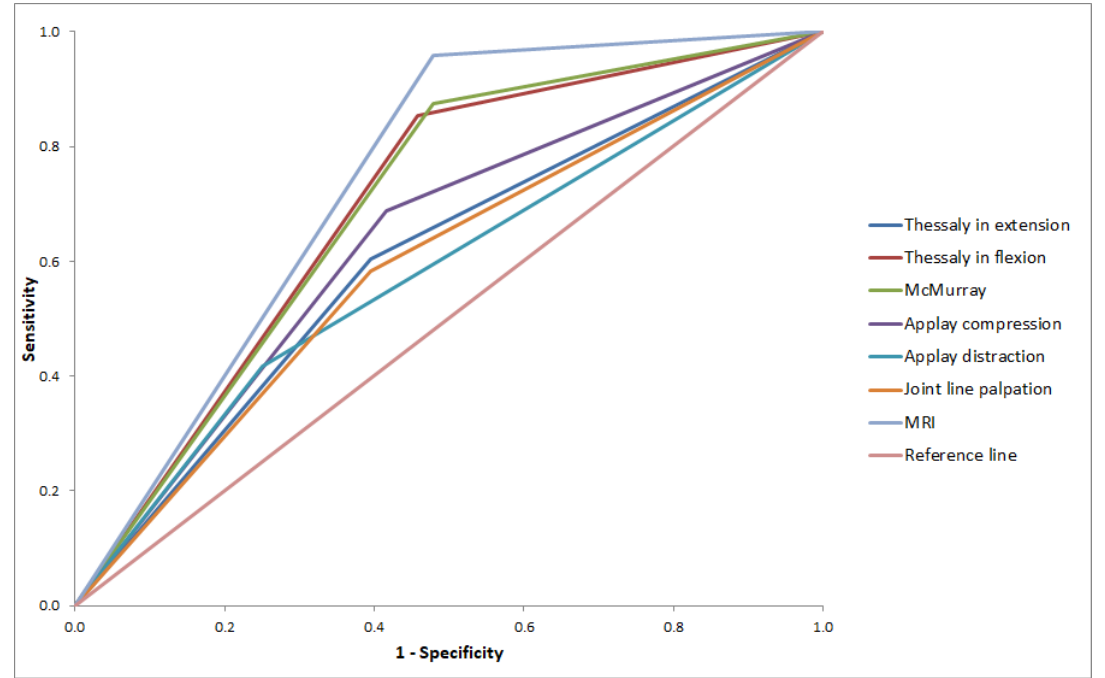
Figure 1. ROC curve describing the relation of sensitivity to specificity in the diagnostic tests for the medial meniscus.